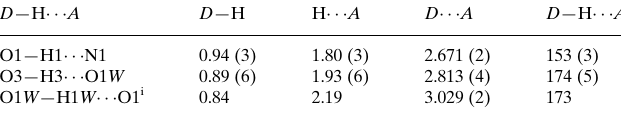
STOE IPDS II two-circle- diffractometer